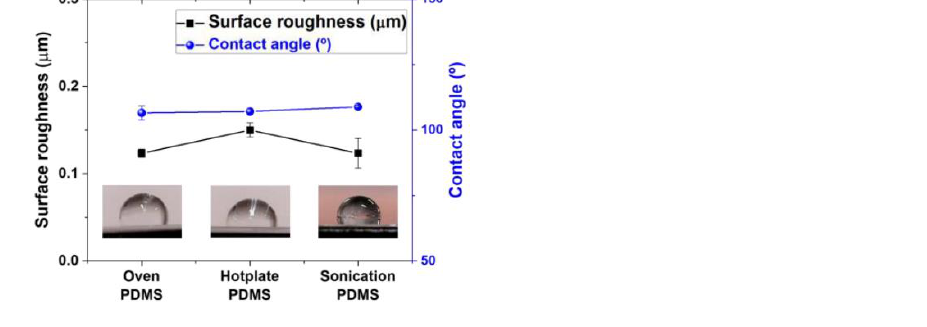
Figure 2. Surface roughness and contact angles of water droplets on PDMS thin films. Insert images: Microscopic camera images of water droplets on the surface of the PDMS thin films under different curing methods.